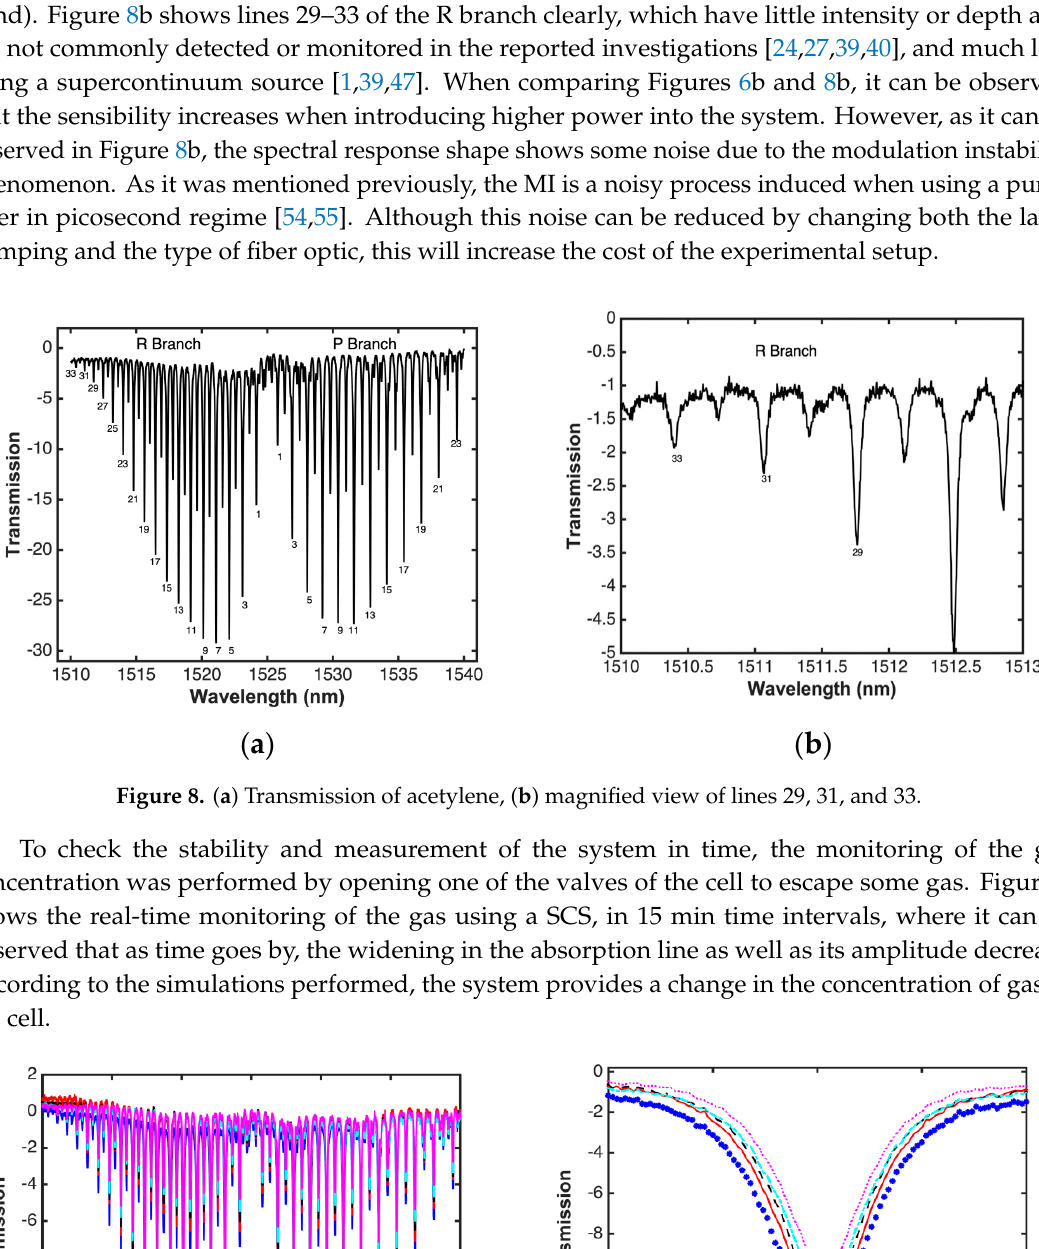
Figure 9. ( a ) Real-time gas monitoring with the OSA , ( b ) magnified view of 1530.2–1530.6 nm region.